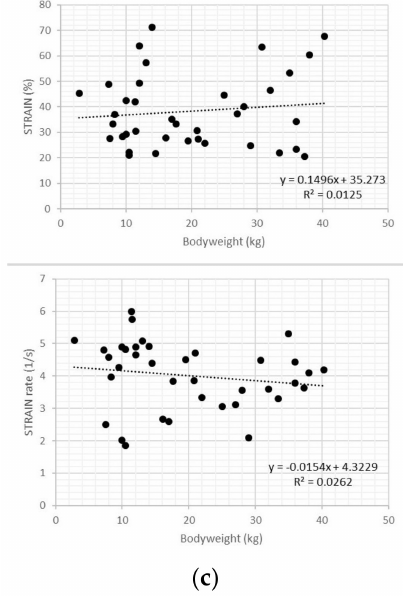
Figure 3. Scatter plots of transverse strain and strain rate values in healthy dogs showed no relationship with heart rate ( a ), age ( b ), and bodyweight ( c ). In dogs with PH, transverse strain and strain rate values showed weak negative relationships with TR velocity (r 2 = 0.24 and r 2 = 0.25, respectively; p = 0.006 for both variables), but no relationship with LA:Ao (r 2 = 0.05 and r 2 = 0.06, respectively; p = 0.2 for both variables) (Figure 4).